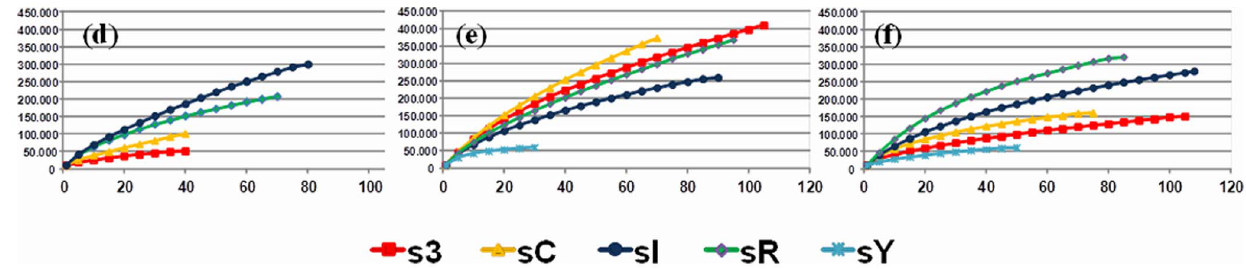
Figure 1. Rarefaction analysis of alkB clone libraries using a distance level of 97% similarity. The clone libraries are denoted as follows: the letters (d), (e) and (f) correspond to the alkB -targeting primers described in Table 1, and sI, sR, sY, s3 and sC are the sampling site codes (described